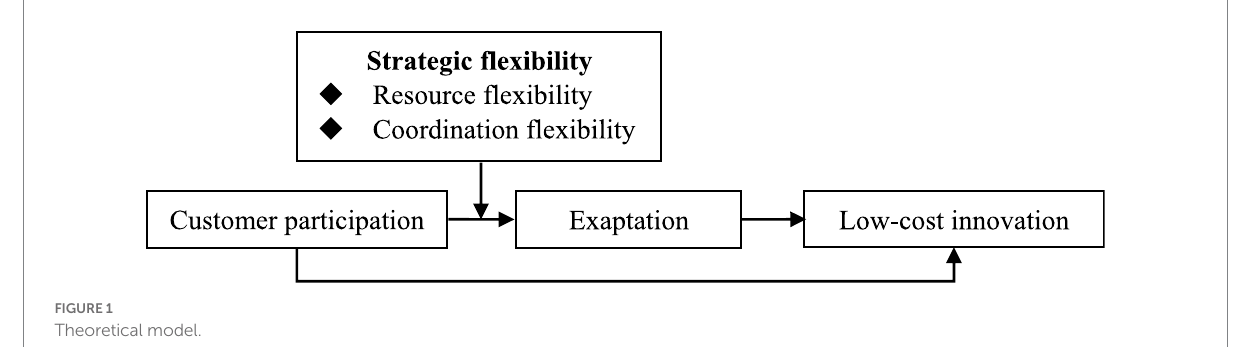
FIGURE 1 Theoretical